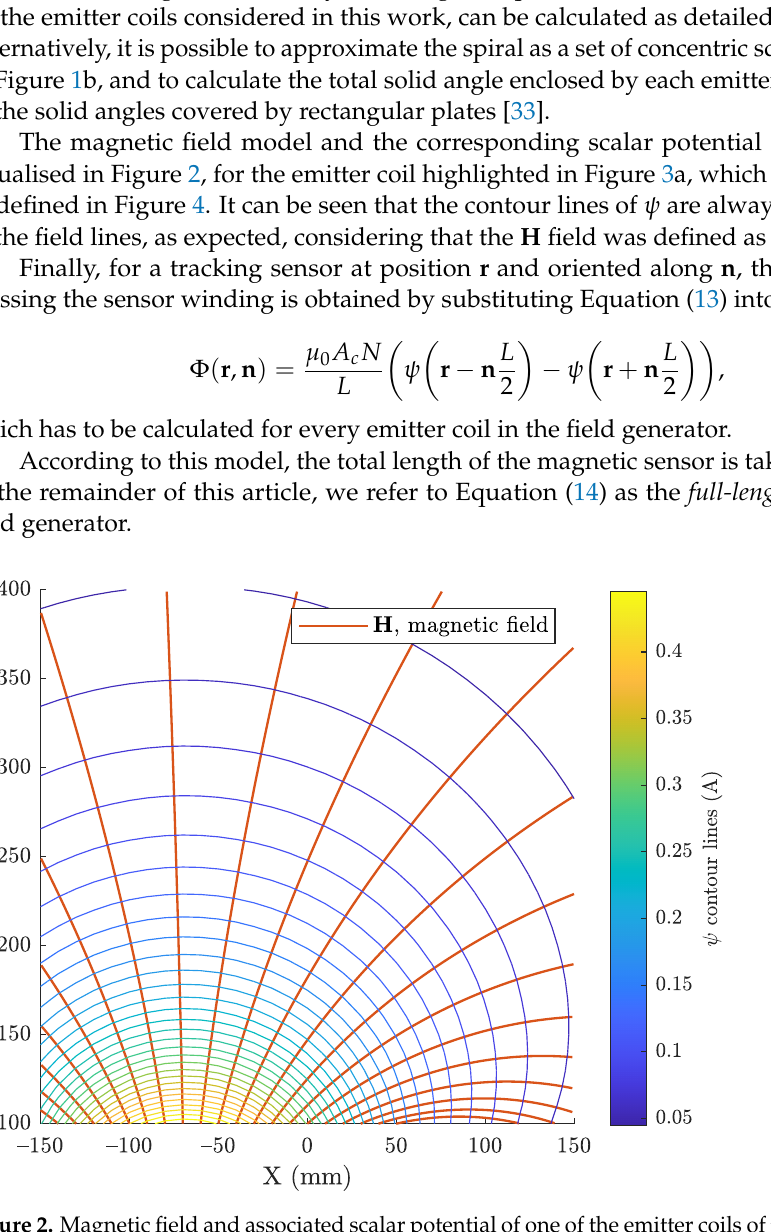
Figure 2. Magnetic field and associated scalar potential of one of the emitter coils of the field generator, evaluated on an XZ plane at Y =